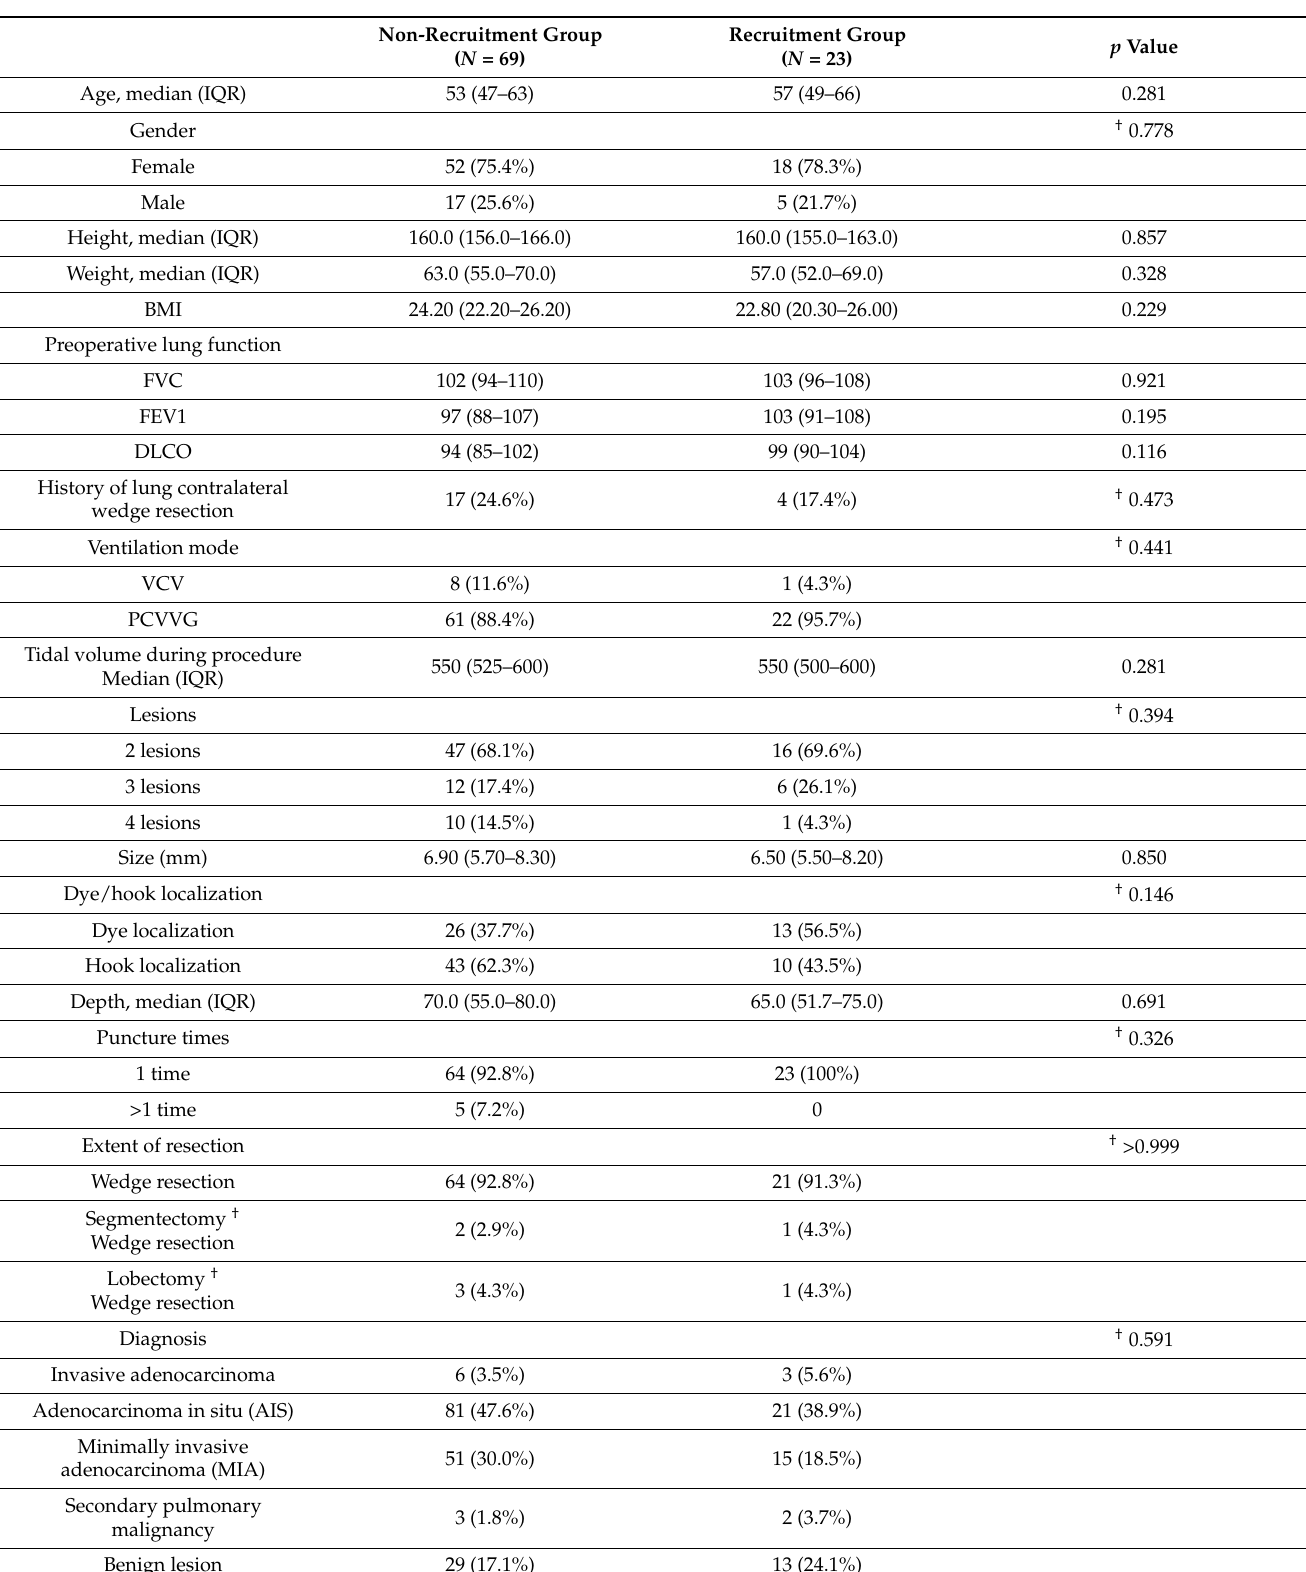
Table 1. Characteristics of the study